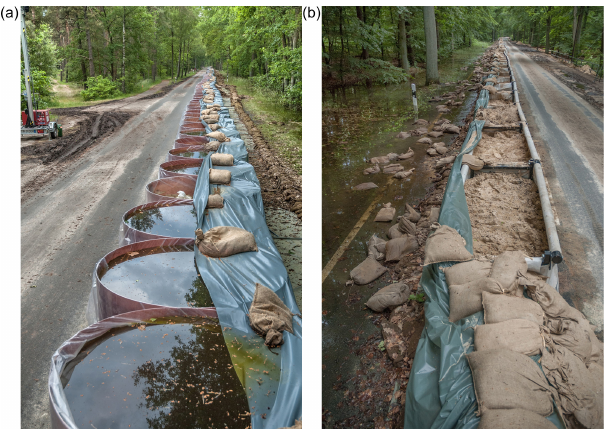
Figure 4. SBRSs near Gartow (Lower Saxony, Germany) after the Elbe flood in 2013 using (a) AQUARIWA and (b) Quick Damm Type